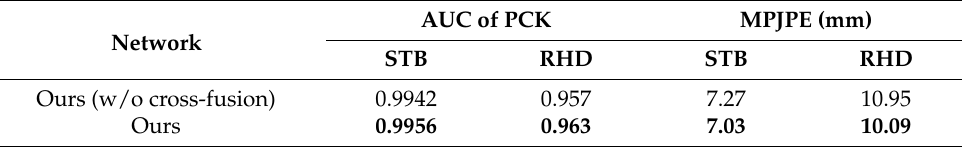
Table 4. Error analysis of the cross-fusion module